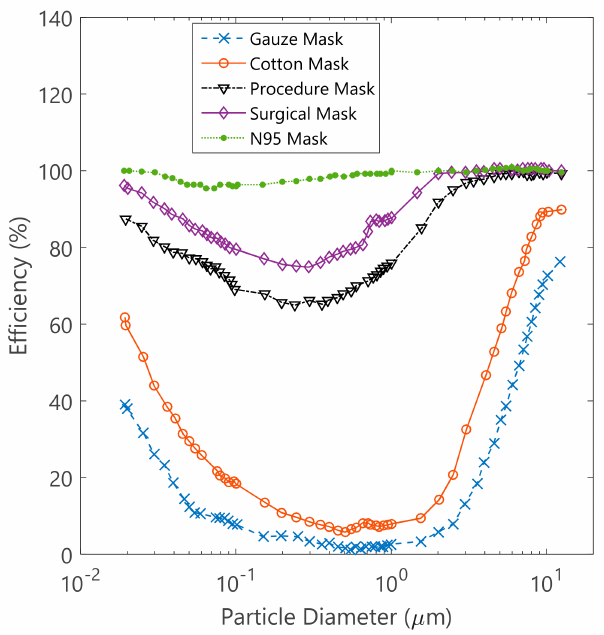
Figure 3. Efficiency data of the mask are taken from [29].